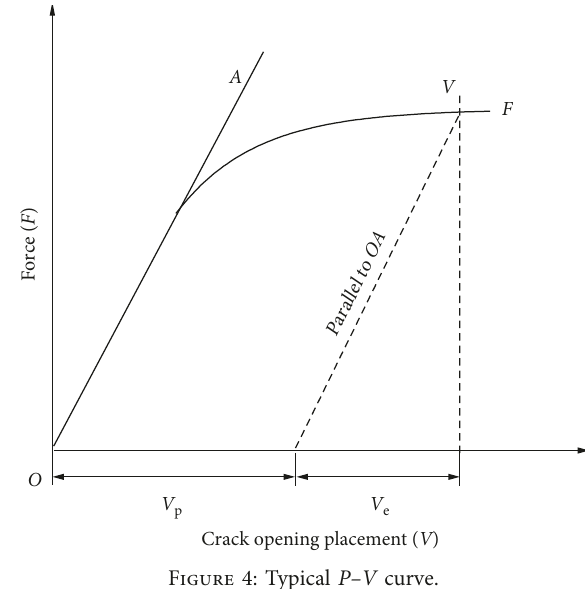
Figure 4: Typical P–V curve.